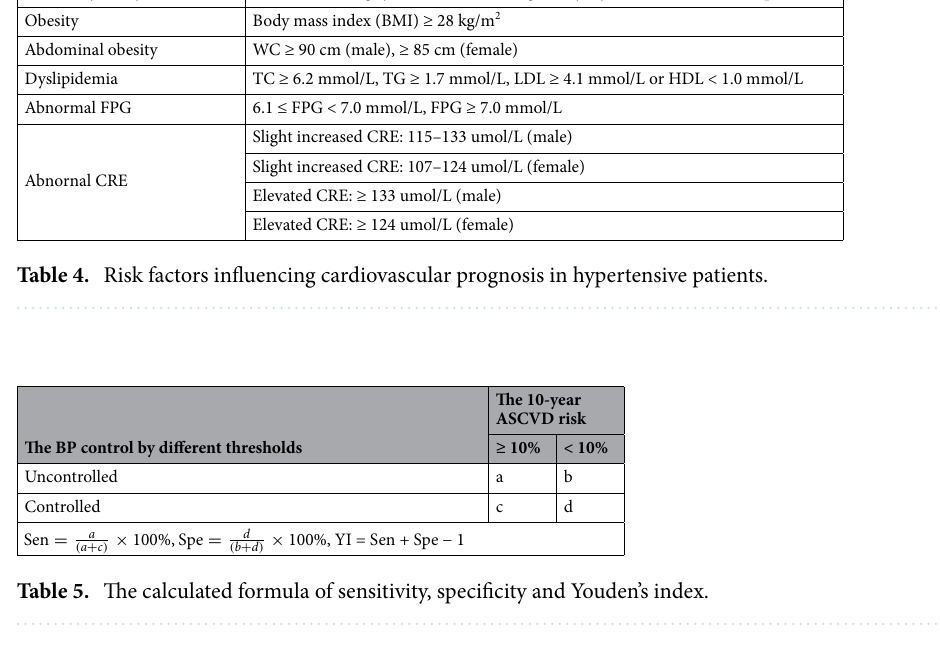
Table 5. The calculated formula of sensitivity, specificity and Youden’s index.